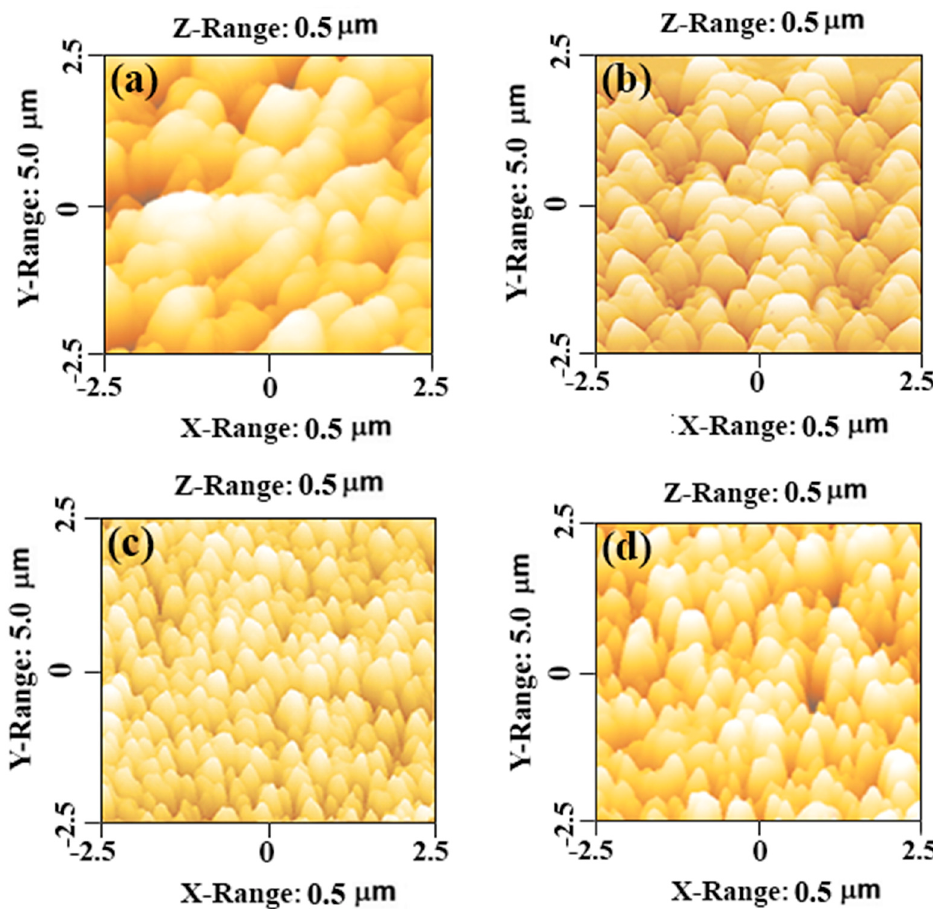
Figure 3. AFM Images of ( a ) TaC, ( b ) HfC, ( c ) (Ta 30 -Hf 70 -C) and ( d ) (Ta 70 -Hf 30 -C).